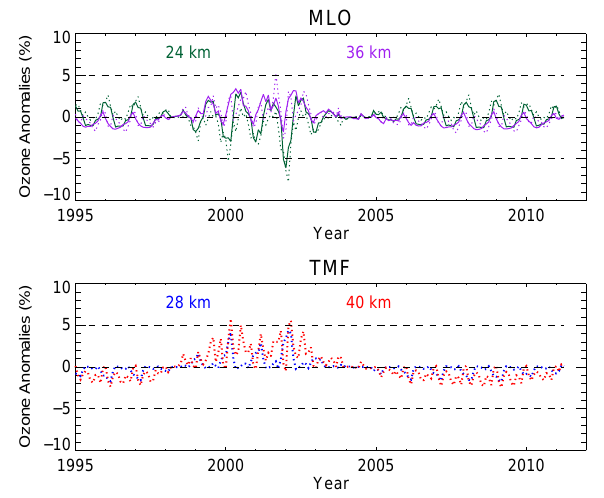
Fig. 9. Ozone response to ENSO perturbations at 22 (blue) and 30 (red) km over MLO and TMF. Lidar responses are solid lines and satellite are dotted